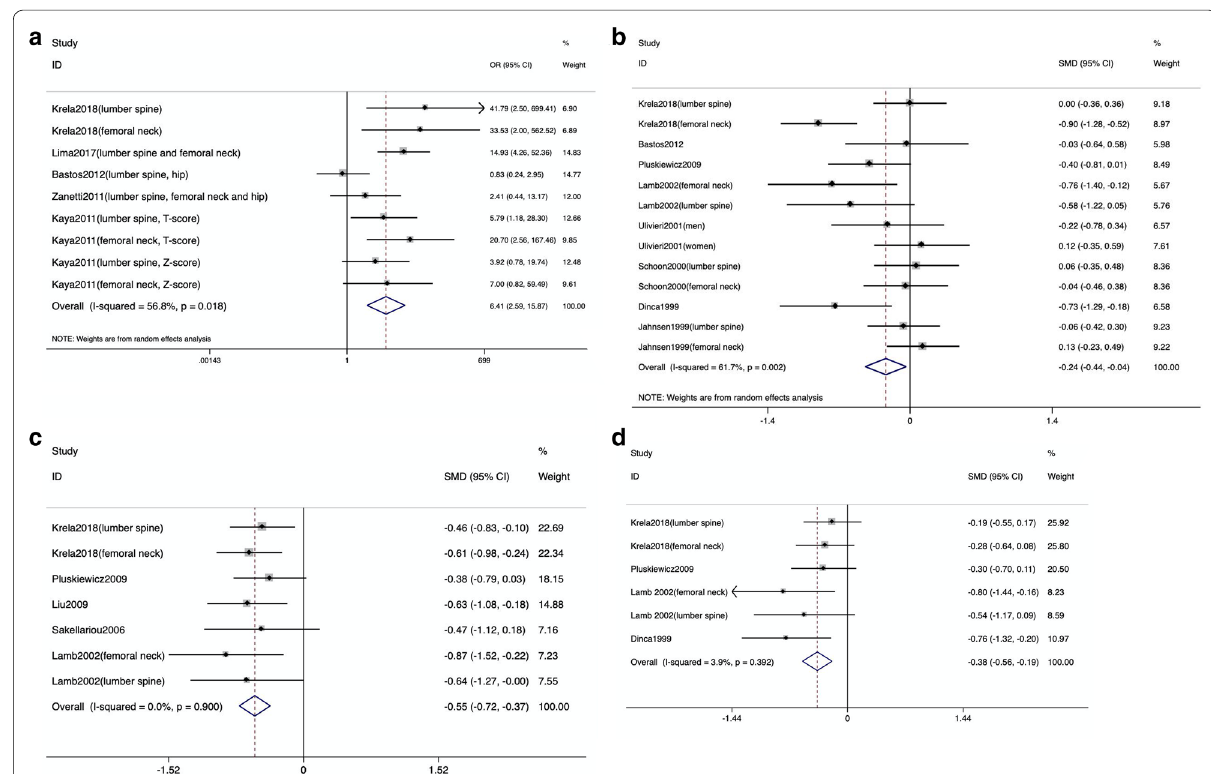
Fig. 2 Meta-analyses of bone mineral density in ulcerative colitis patients. A Pooled odds ratio (OR) for the association between low bone mineral density and ulcerative colitis. The pooled OR was calculated using the random-effects model. B Pooled standardized mean difference (SMD) for bone mineral density in the participants. The pooled SMD was calculated using the random-effects model. C The SMD for the t-score in participants. The pooled SMD was calculated using the fixed-effects model. D The pooled SMD for the z-score in participants. The pooled SMD was calculated using the fixed-effects